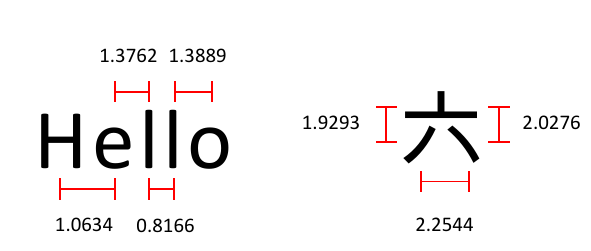
Figure 2. Process Overview.